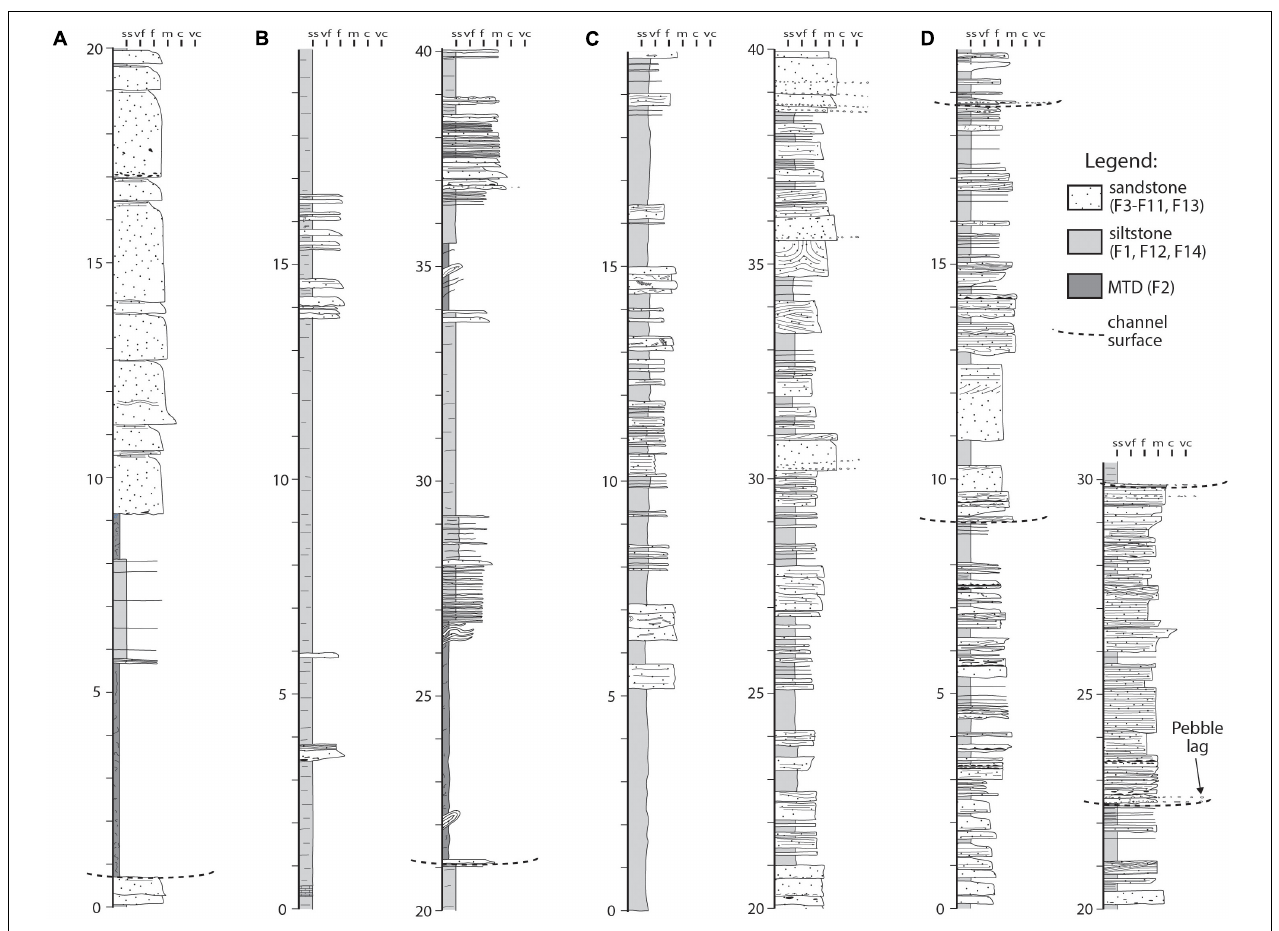
FIGURE 7 | Measured sections at selected outcrop locations, with locations of channelized erosion surfaces indicated. (A) Submarine channel fill in the basal Figueroa clinothem package (location 7A in Figures 2C , 3 ). (B) Background slope deposits, including abundant fine-grained concordant strata as well as chaotically bedded MTD’s in the upper Figueroa clinothem (location 7B in Figures 2C , 3 ). (C) Overall upward coarsening succession of the Oveja shelf-margin topset (location Toro in Figures 2C , 3 ). (D) Heterolithic channel fills at the Puma clinoform shelf margin; extrabasinal clast lags often mantle erosion surfaces (location CN2 in Figures 2C , 3